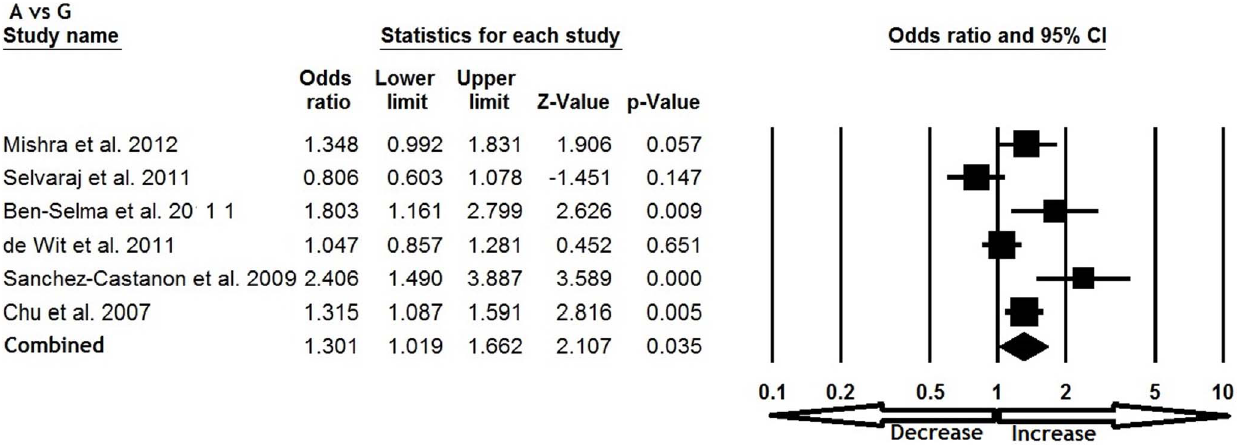
Figure 1. Forest plot and ORs with 95% CI of CCL5 -403G . A polymorphism and TB risk (A vs. G).